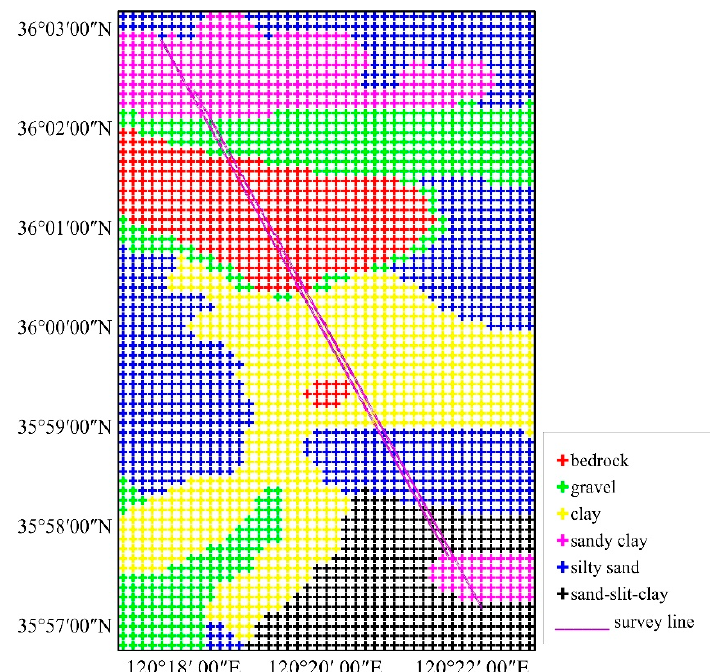
Figure 4. Distribution of seabed sediment characteristics.